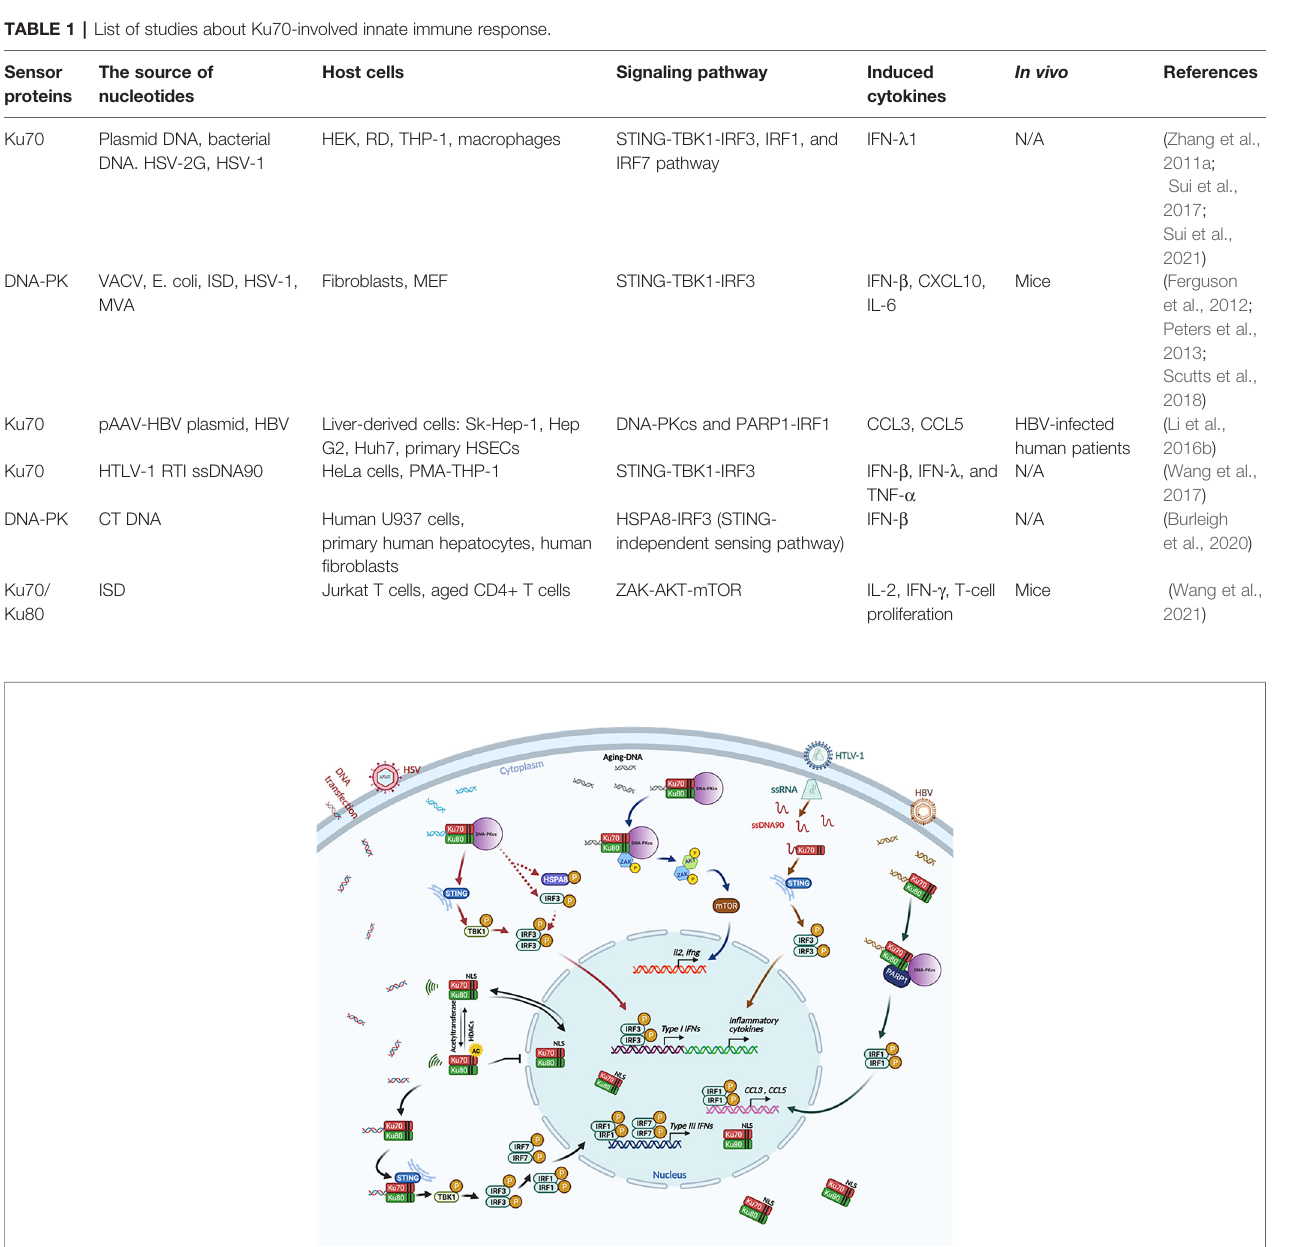
FIGURE 3 | The involvement of Ku70 as a cytosolic DNA sensor to activate the innate immune response. Ku70 is identi fi ed as a cytosolic DNA sensor that induces type III IFNs through a STING-TBK1-IRF3, IRF1, and IRF7 signaling pathway. In this signaling pathway, cytoplasmic translocation of Ku70 is an initial and essential step (black arrows) (Zhang et al., 2011a; Sui et al., 2017; Sui et al., 2021); Ku70 and Ku80, together with DNA-PKcs (DNA-PK), are also involved in a STING- dependent (Ferguson et al., 2012) (solid arrow) and STING-independent (Burleigh et al., 2020) (dashed arrow) pathway to induce type I IFNs (red arrows). Ku70 is reported to sense HTLV-1 transcription intermediate product ssDNA90 and interacts with STING to induce IFNs and in fl ammatory cytokines, thereby modulating HTLV-1 replication (Wang et al., 2017) (brown arrows). The Ku70/80 heterodimer recognizes HBV-infection-derived DNA, then activates DNA-PKcs and PARP1 to induce CCL3 and CCL5 in fl ammatory cytokines (Li et al., 2016b) (green arrows). DNA-PK (the complex of DNA-PKcs, Ku70, and Ku80) senses aging-related cytoplasmic DNA in CD4+ T cells. This DNA sensing then induces T-cell proliferation and activation, as well as autoimmunity through the ZAK-AKT-mTOR pathway (Wang et al., 2021) (blue arrows). This illustration was created by using